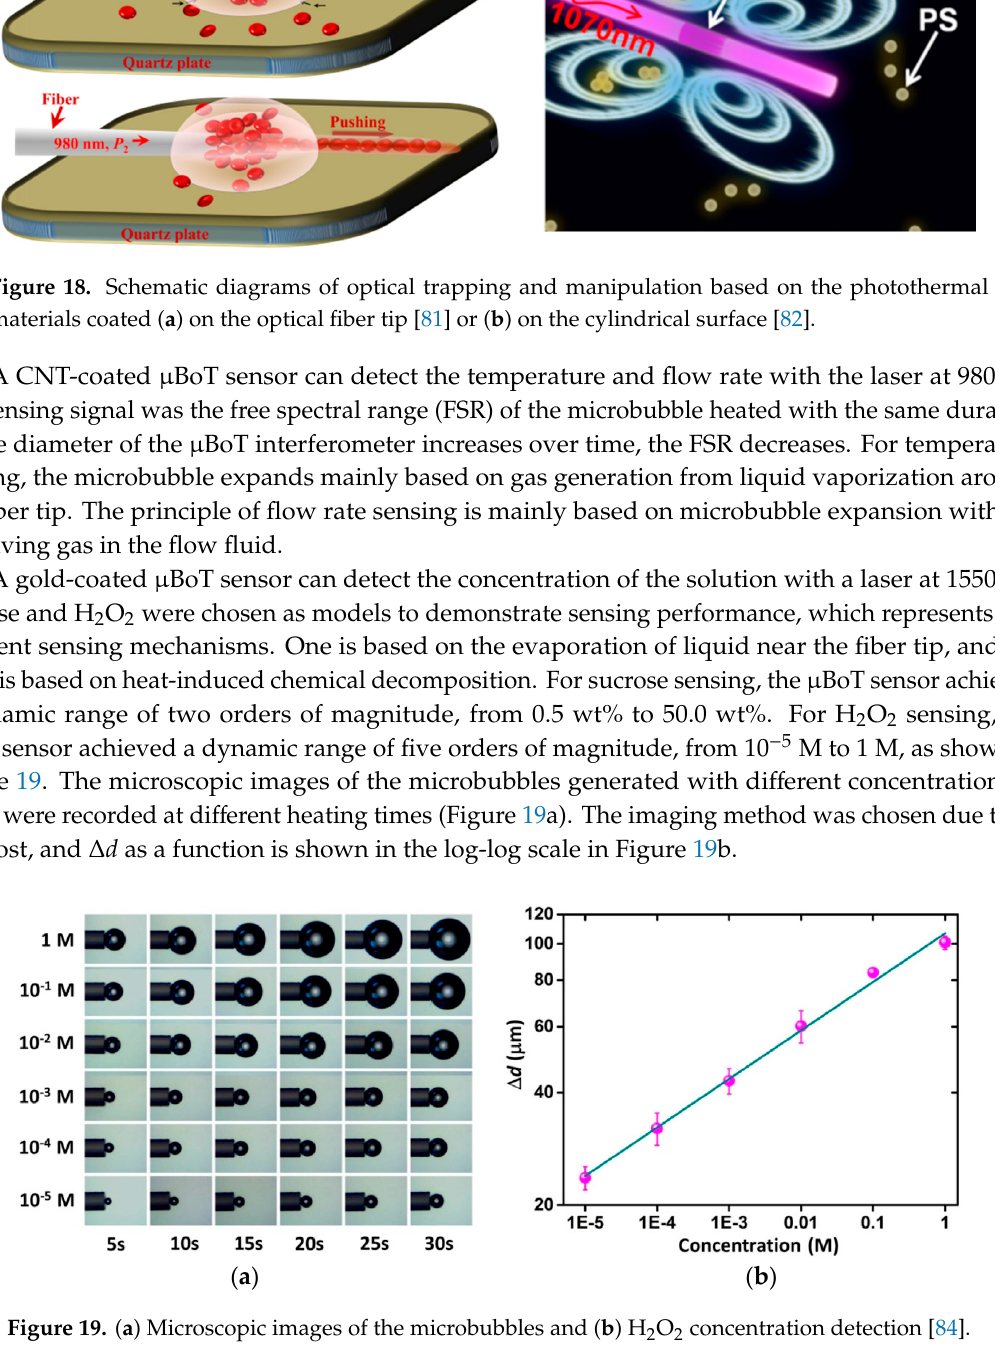
2 O 2 concentration detection